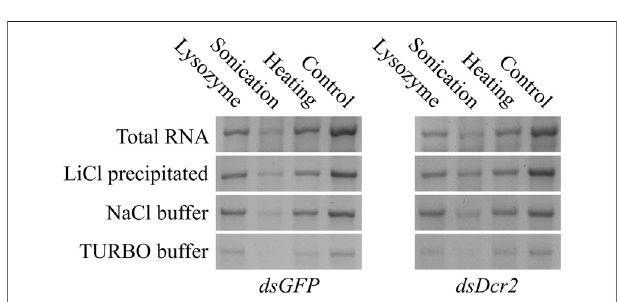
FIGURE 4 | Comparison of dsGFP (~700 bp) and dsDcr2 (~650 bp) bands of total and puri fi ed RNA. For each condition, 400 ng total RNA or dsRNA puri fi ed from 400 ng total RNA were loaded onto a 1% agarose gel in TAE buffer. The RNA was separated by size through agarose gel electrophoresis at 120V for 2 h. The nucleic acids were imaged with the GelRed ® (Biotium) stain under UV light.